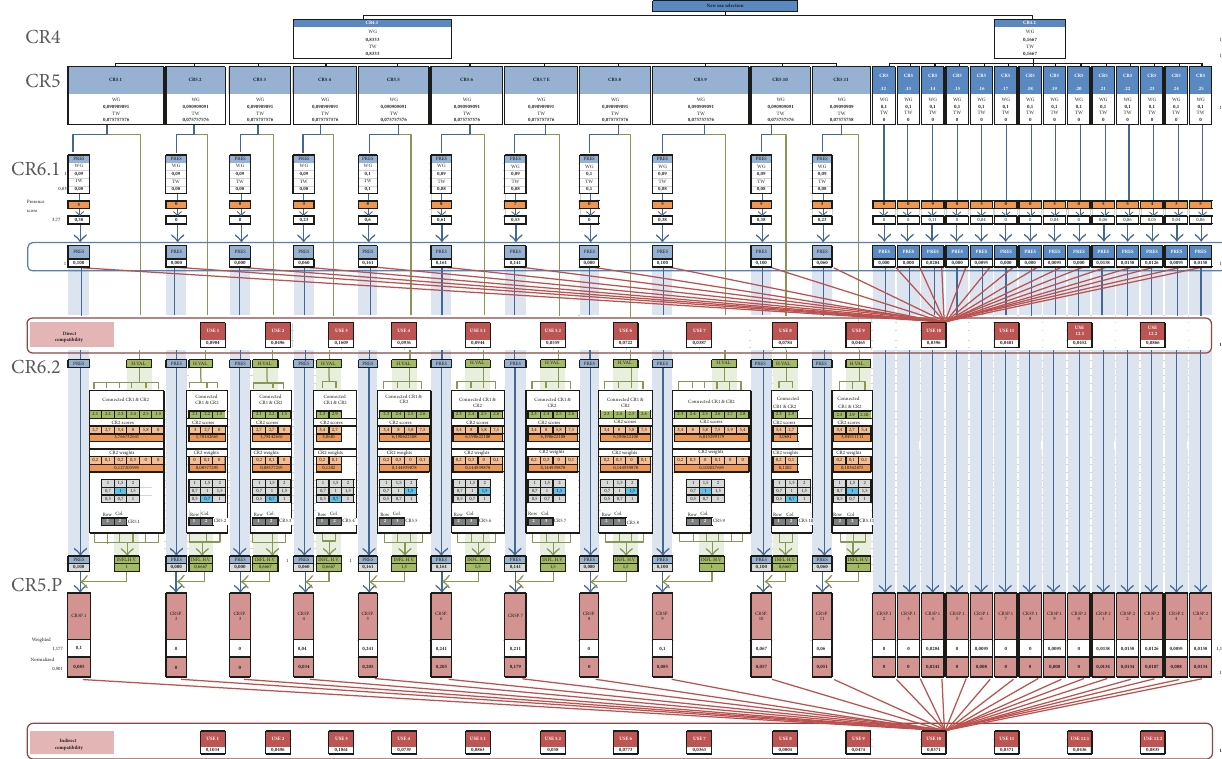
Figure 7: Hierarchical structure of criteria for selection of new uses.